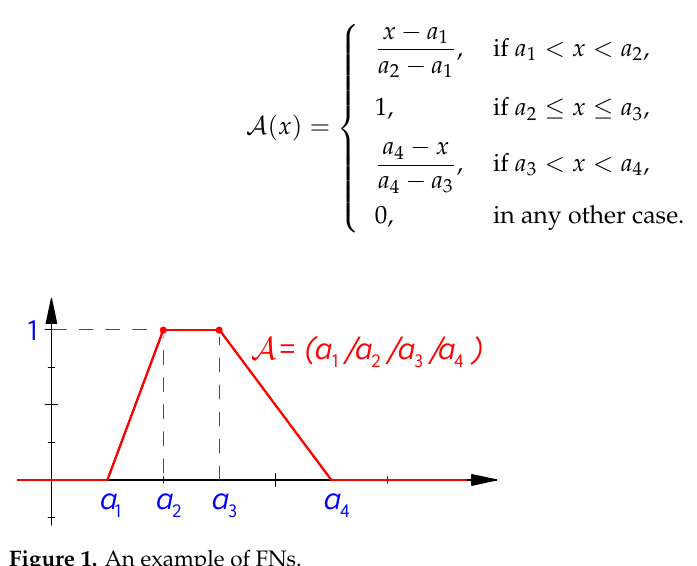
Figure 1. An example of